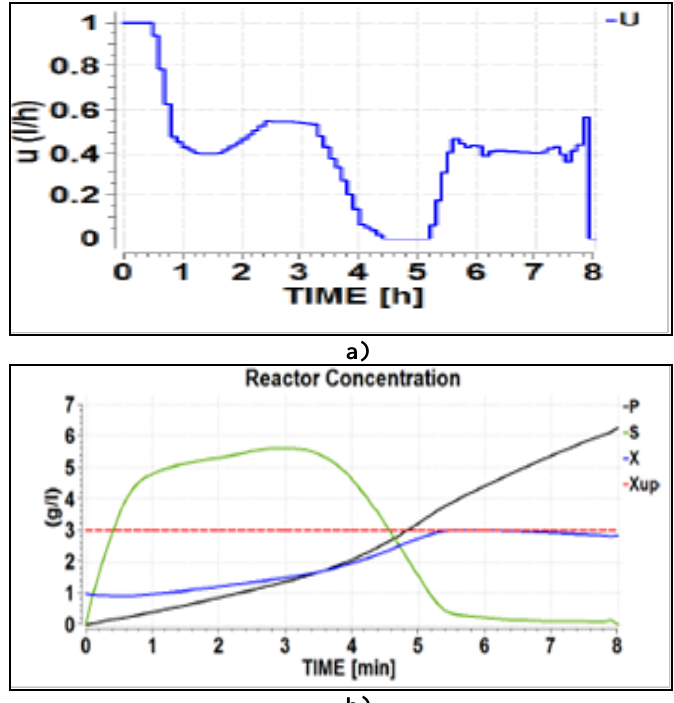
Figure 15: (a) Manipulated and (b) constrained variables.